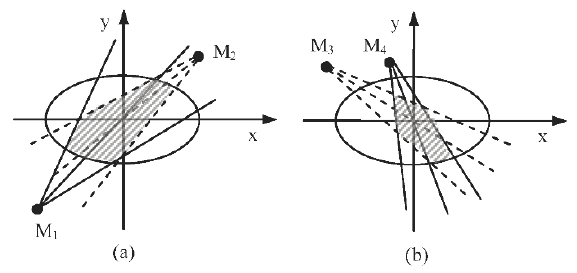
Figure 5. Effection of node’s location in information utility measure: ( a ) the jointed sensing information utility of sensed module M 1 and M 2 ; ( b ) the jointed sensing information utility of sensed module M 3 and M 4 .